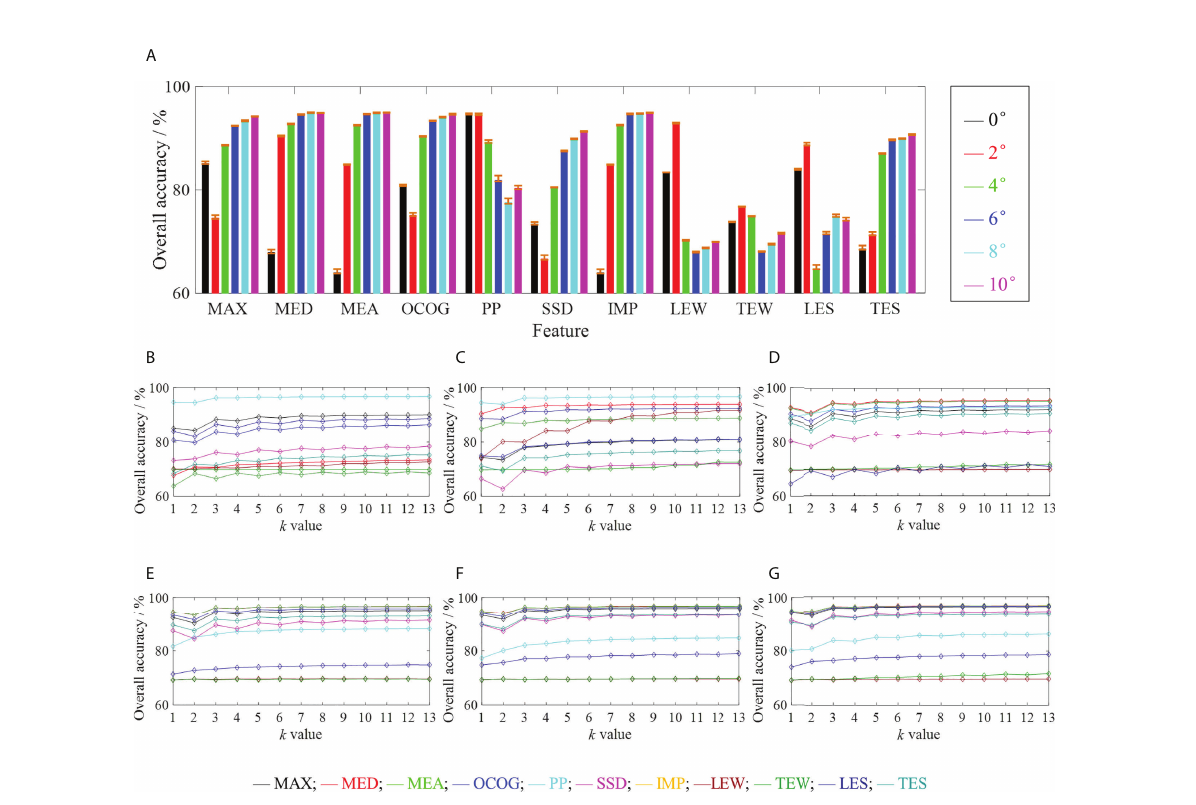
FIGURE 4 Overall accuracies of the RF method for different tree numbers and the KNN method for different k values at small incidence angles: (A) Different numbers of RF trees: Mean values of the overall accuracies are expressed by the bars; The maximum value and minimum value of the overall accuracies are indicated by two orange short lines on the bar, respectively; The upper line represents the maximum value, and the lower line is the minimum value; (B) Different k values at 0°; (C) Different k values at 2°; (D) Different k values at 4°; (E) Different k values at 6°; (F) Different k values at 8°; (G) Different k values at